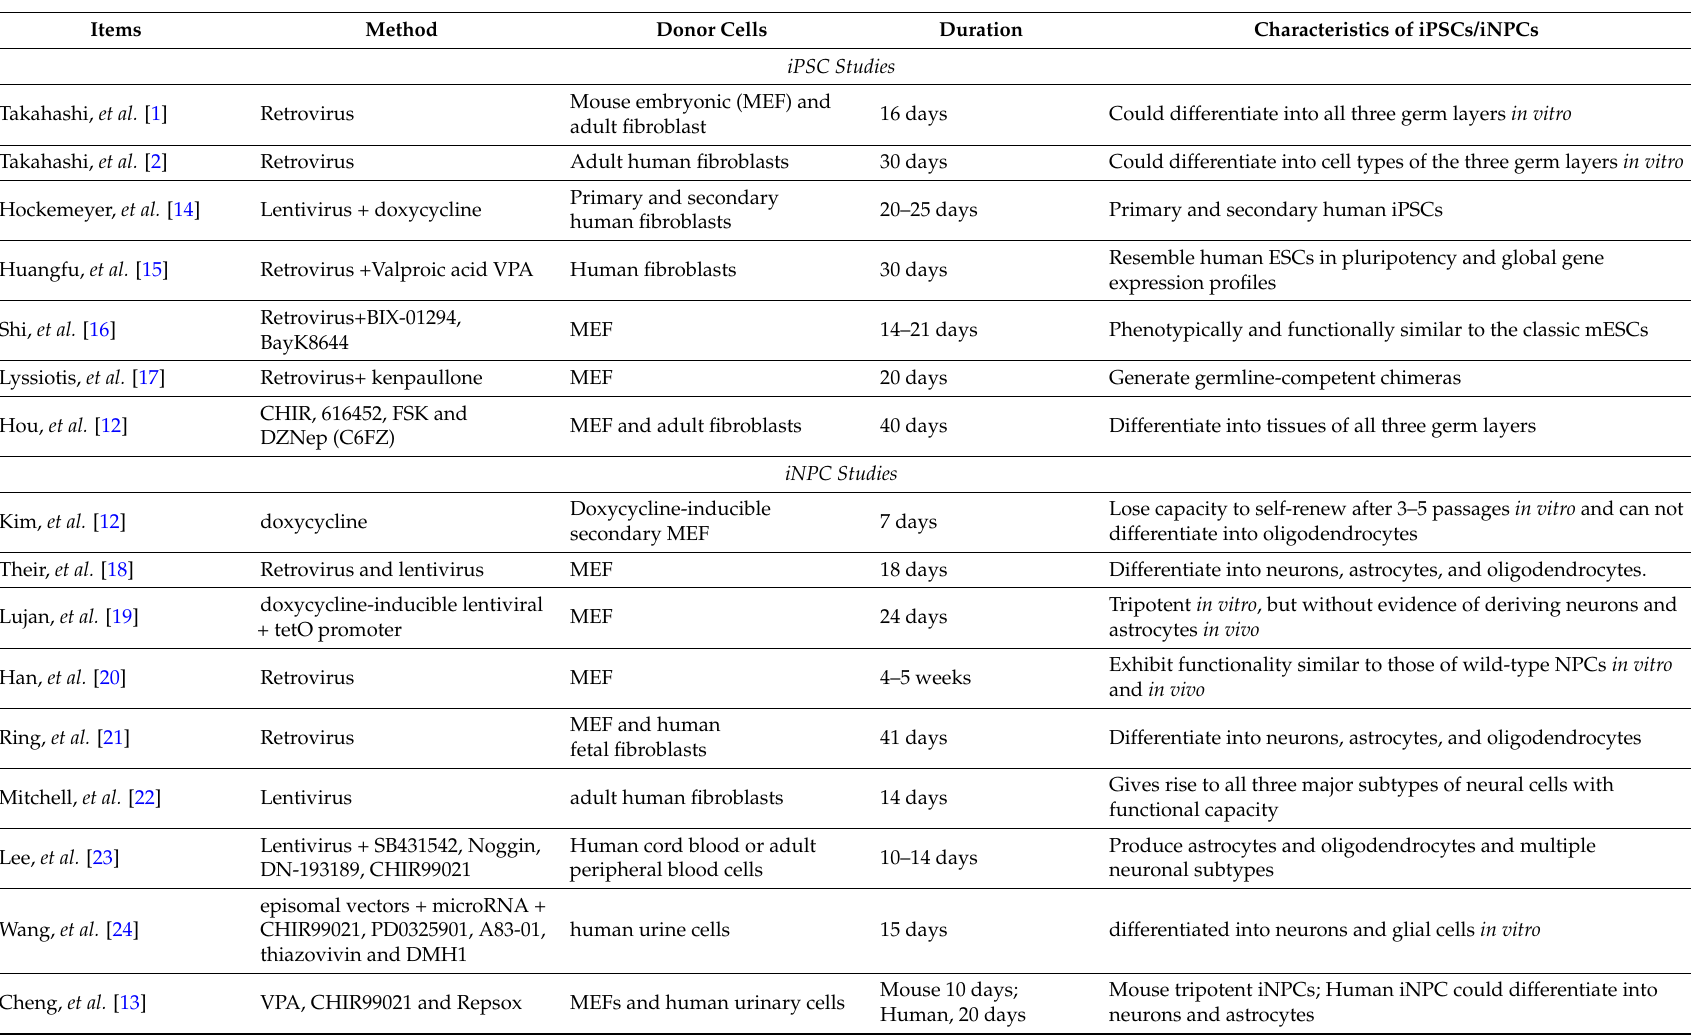
Table 1. Summary of viral and chemical reprogramming of induced pluripotent stem cell (iPSC) and induced neural precursor cell